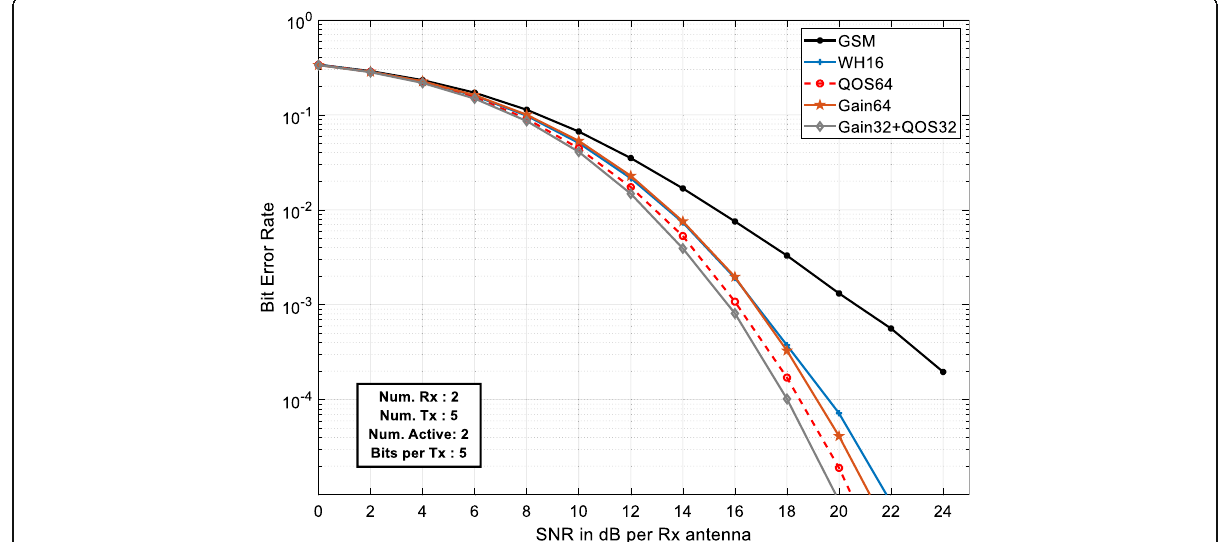
Fig. 6 BER performance of GSM-FP system with codebook precoding and fixed TAC-set at N t = 5, N a = 2, and N r =